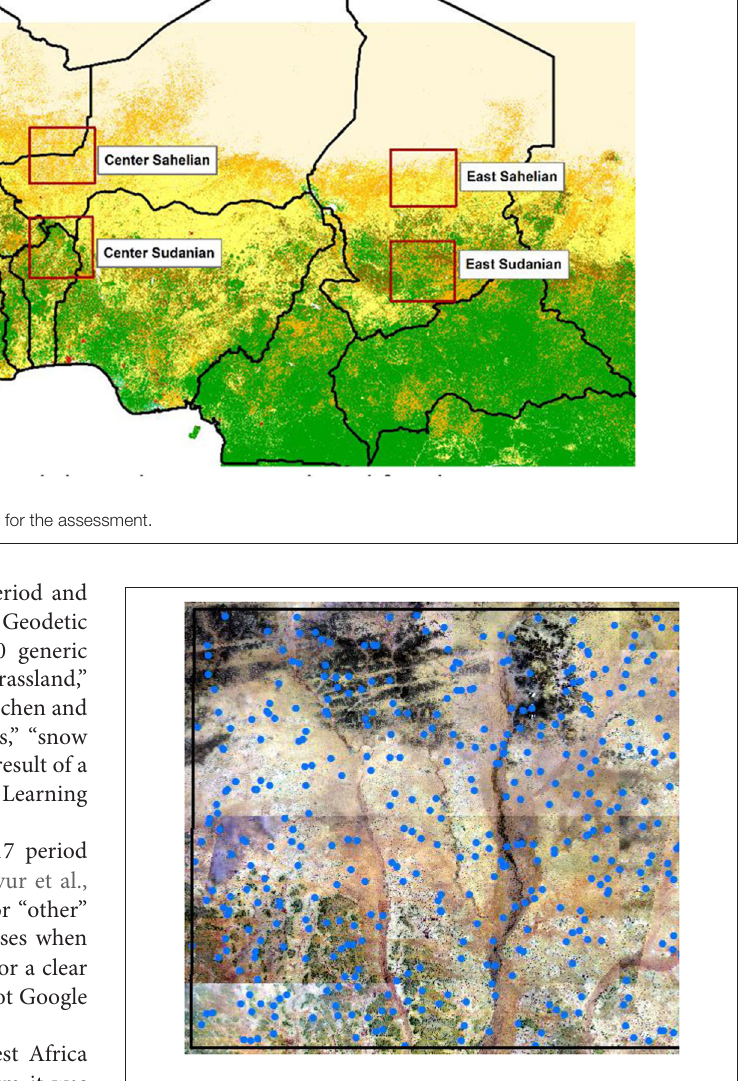
FIGURE 2 | Validation point sample over Central Sahel